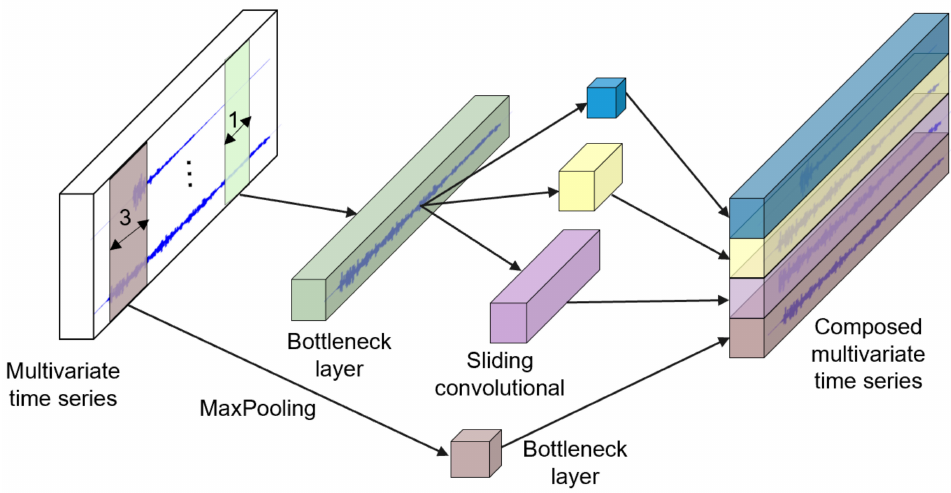
Figure 5. Inside InceptionTime module for TSC with a bottleneck layer of size m =